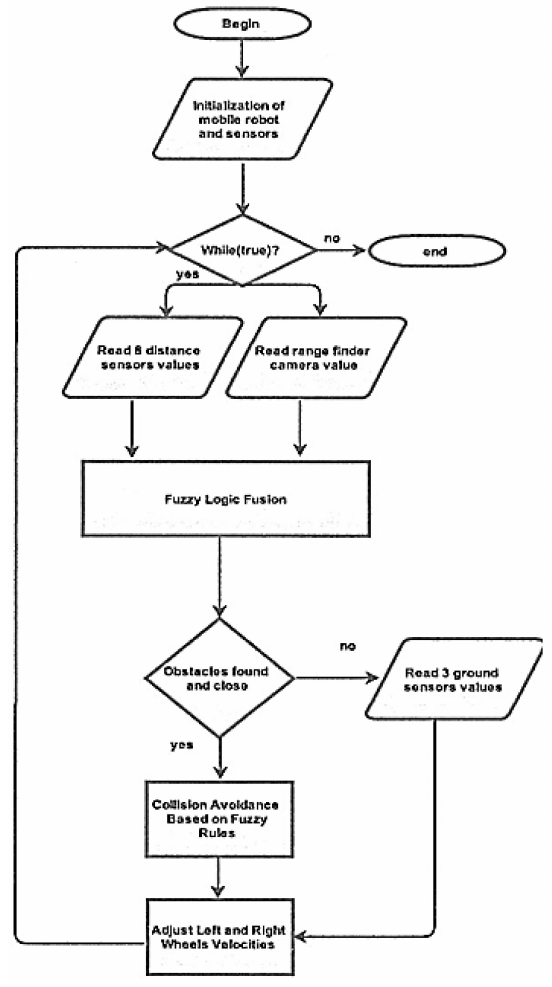
Figure 7. Flowchart of the proposed